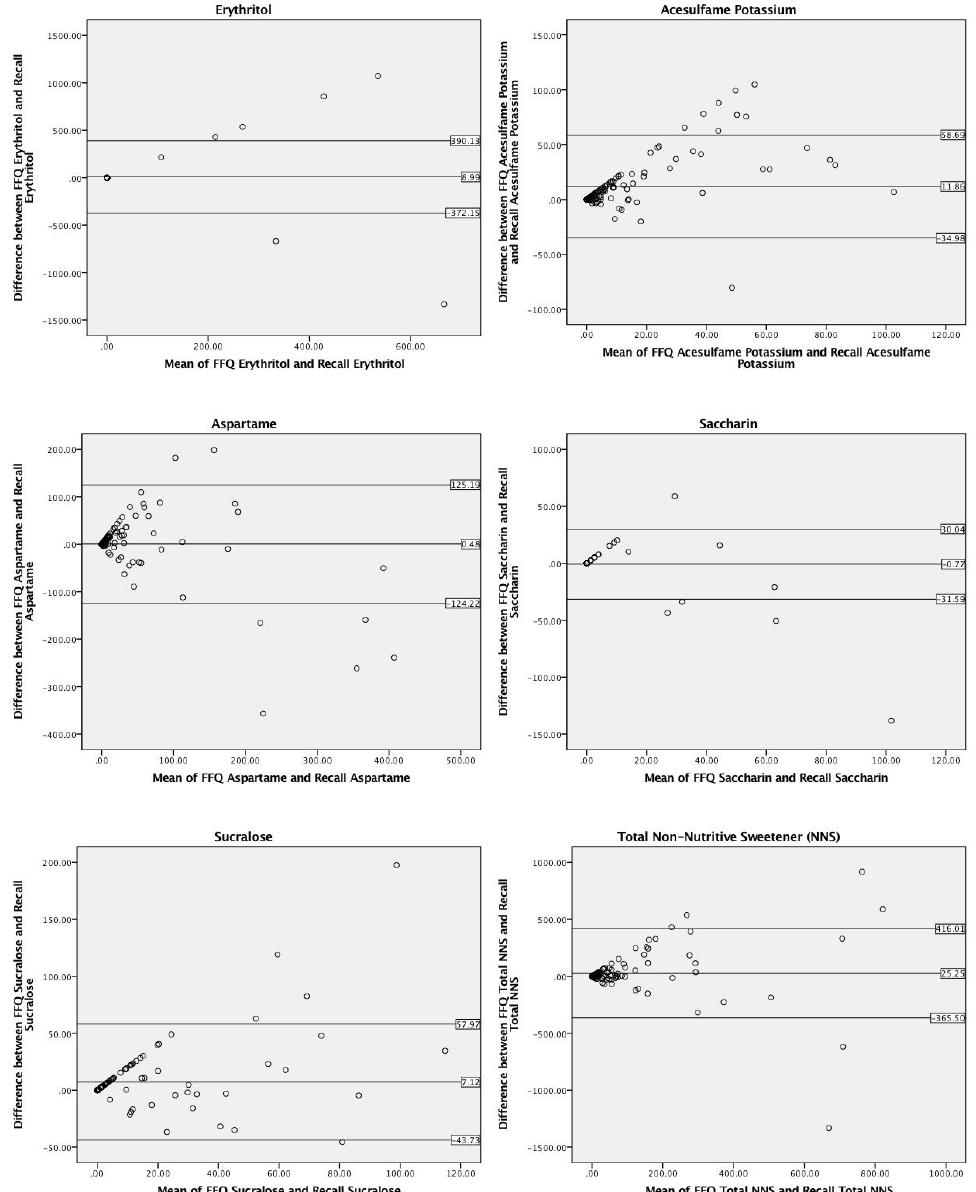
Figure 3. Bland–Altman plots of total and individual non-nutritive sweetener (NNS) mg consumption via a food-frequency questionnaire (FFQ) and dietary recalls ( n = 123). The center line represents the mean difference and the upper and lower lines indicate the mean ± 1.96 times the standard deviation.